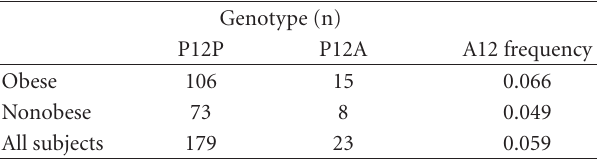
Table 2: PPAR γ 2 genotype frequencies in obese and nonobese Type 2 diabetic patients. The chi-square test was performed for